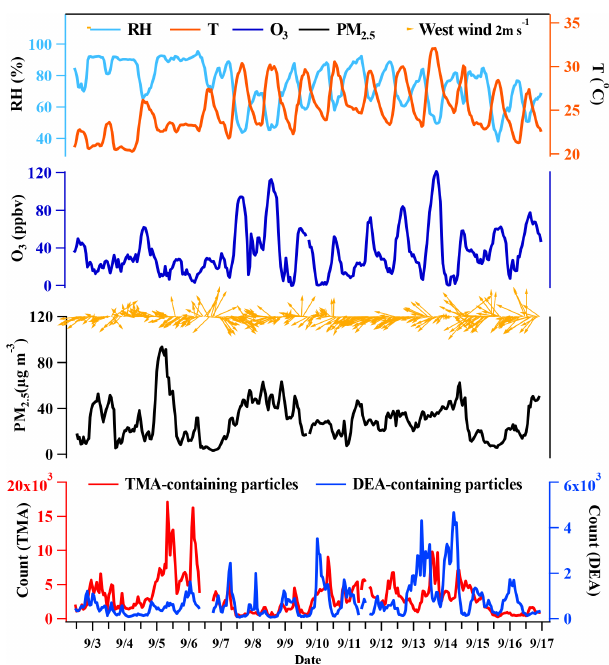
Figure 1. Temporal variations in relative humidity (RH), tempera- ture ( T ), O 3 concentration, PM 2 . 5 concentration, wind speed, wind direction, and TMA- and DEA-containing particles during the en- tire sampling